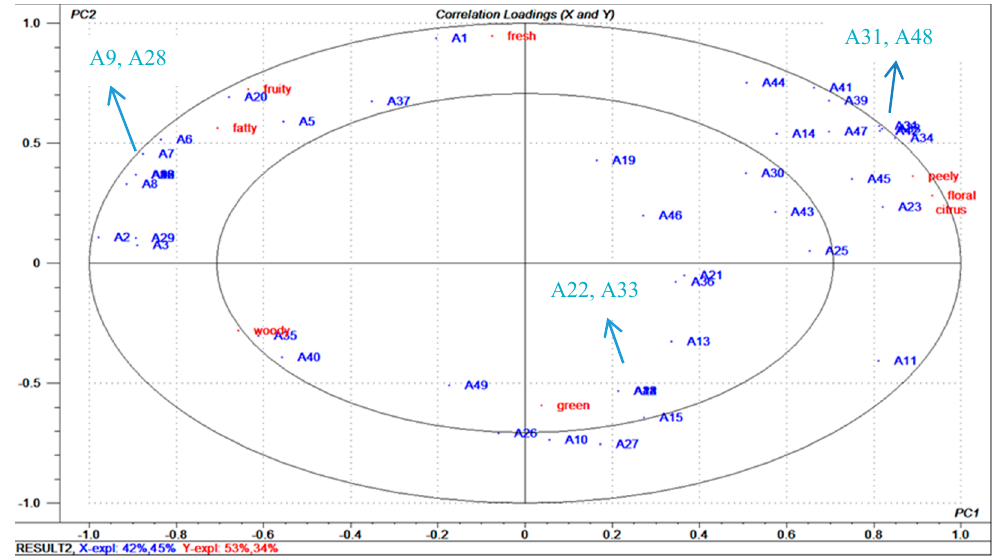
Figure 2. Analysis of correlation between aroma active substances and sensory properties in sweet orange juices (the compound name of A1~A49 is listed in Table 2).